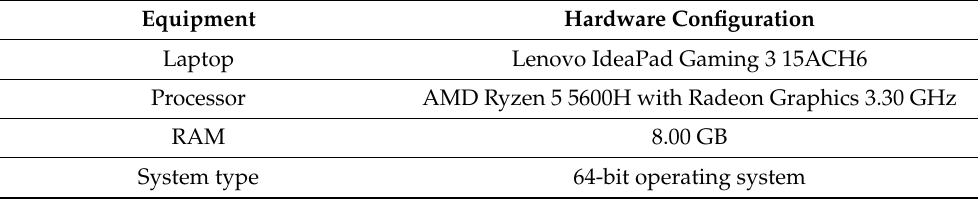
Table 2. Hardware Configuration of Equipment Used.